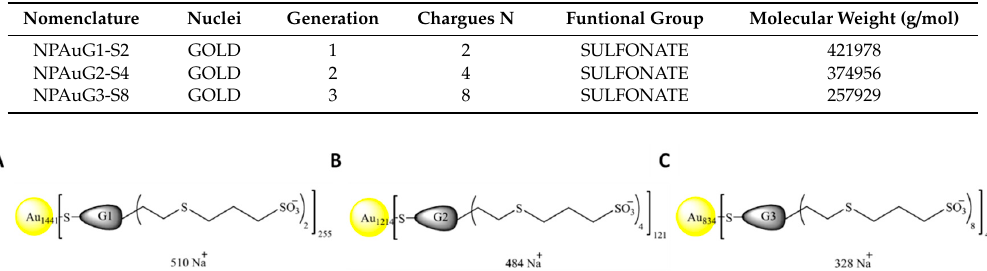
Figure 1. Schematic representation of Gold nanoparticles (NPs). NPs decorated with ( A ) first generation dendron with two sulfonate end groups, ( B ) second generation dendron with four sulfonate end groups and ( C ) third generation dendron with eight sulfonate end groups. The generation of NPs is determined by considering that each generation corresponds to the number of repeating layers of silicon atoms forming the NP.